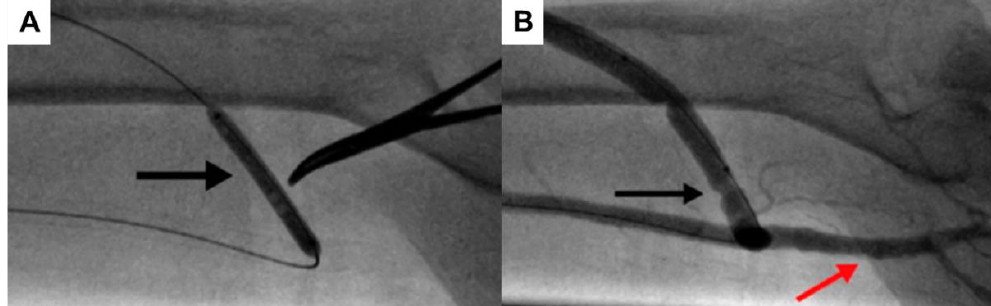
Figure 5. Angiography during minimally invasive limited ligated endoluminal-assisted revascularization (MILLER) procedure. ( A ) An inflated 5 mm angioplasty balloon (black arrow) is guided to the proximal arteriovenous graft (AVG) site. A hemostat is used to designate the area for skin incisions. ( B ) Post-procedure imaging demonstrates a waist in the AVG (black arrow) and distal flow in the brachial artery (red